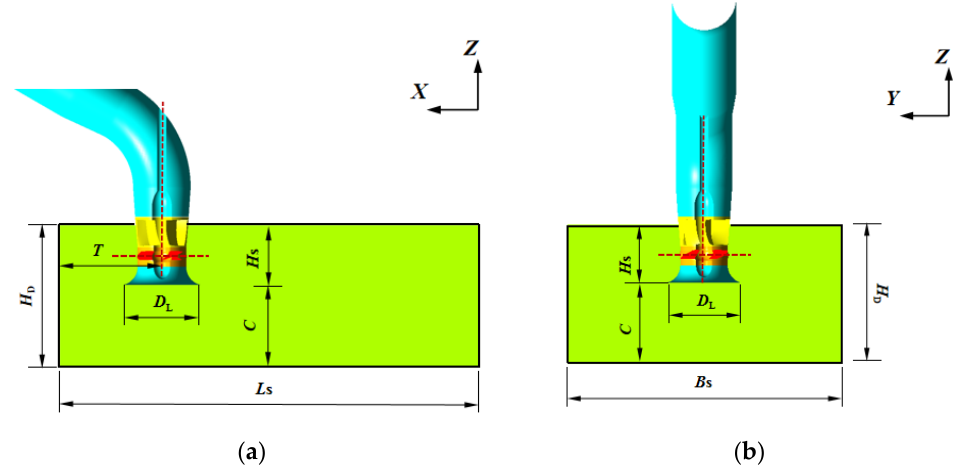
Figure 3. Schematic diagram of geometric parameters of the closed sump. ( a ) Front view. ( b ) Side view.